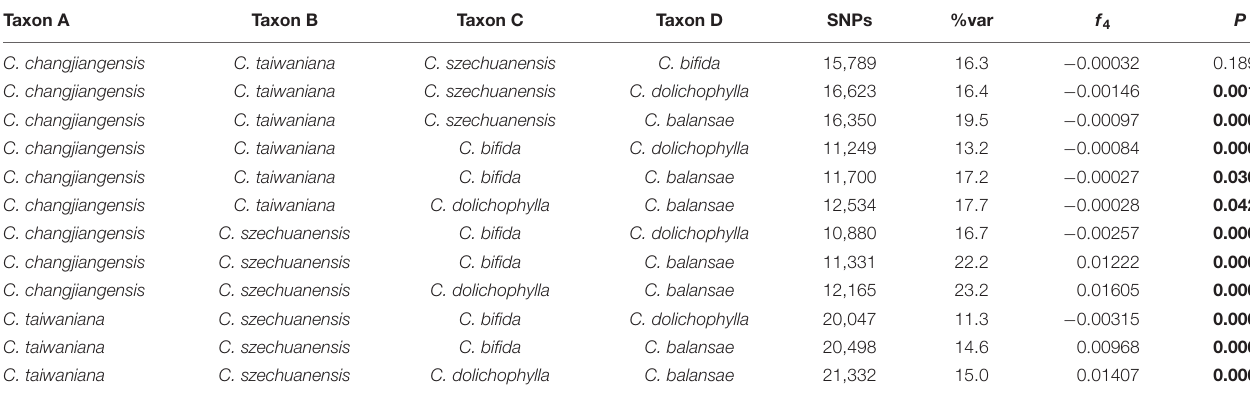
FIGURE 4 | Hybridization among the six Cycas species. (A) Maximum likelihood tree inferred by Treemix, with the gene flow events depicted with arrows; (B) Proposed scenarios for interspecific gene flow revealed by f 4 -statistic and ABBA-BABA test. TABLE 2 | f 4 -statistic for the six Cycas species. f 4 -statistic was calculated in four-taxon comparisons to distinguish interspecific gene flow from incomplete lineage sorting